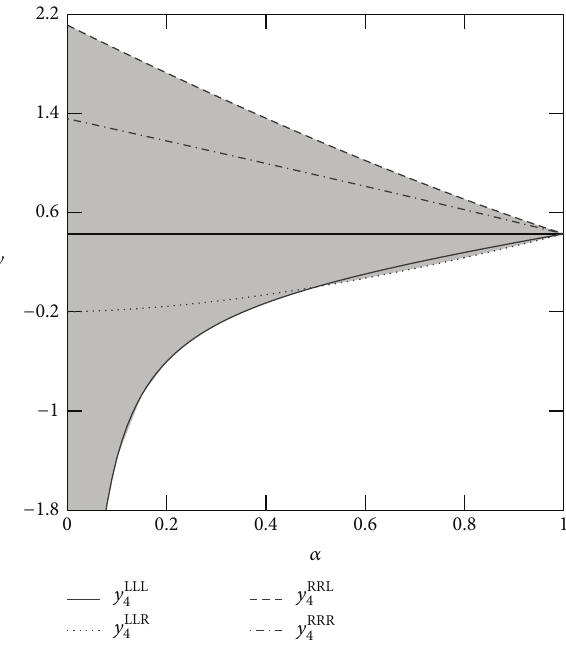
Figure 6: Solution candidates from Example